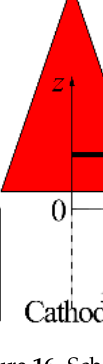
Figure 16. Schematic of the electrode structure with the recommended parameters.